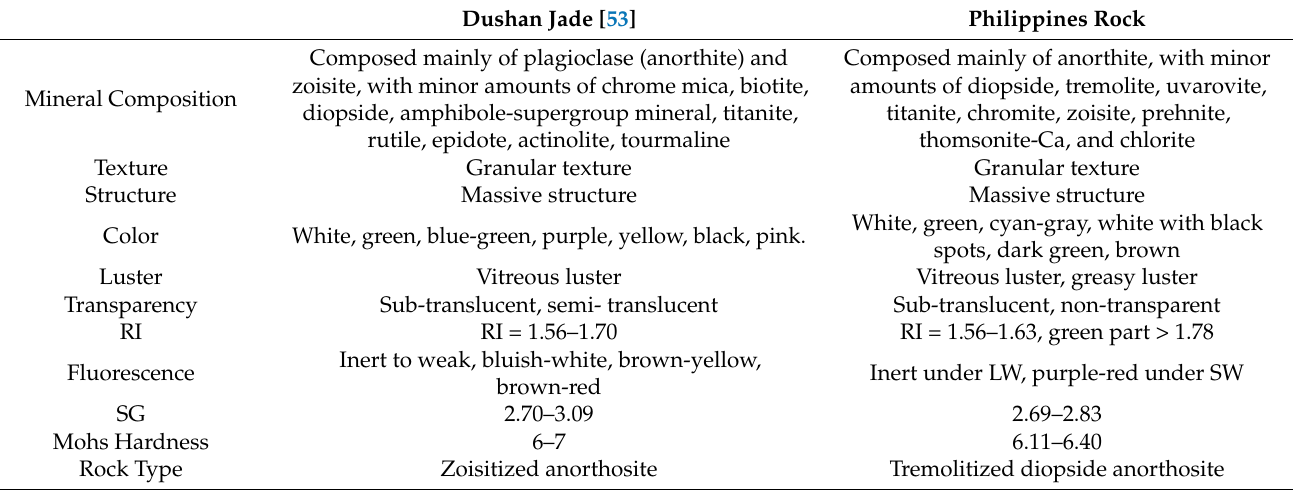
Table 9. Comparison of properties of Dushan jade and Philippines